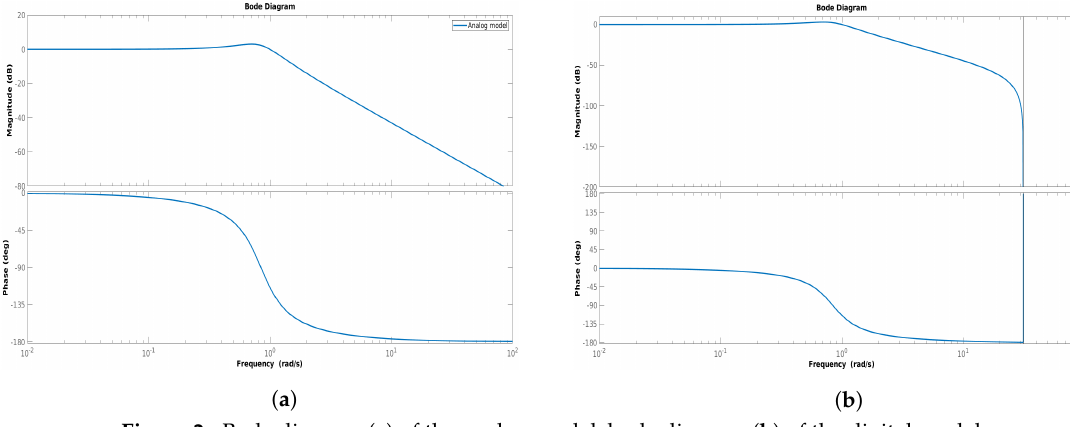
Figure 2. Bode diagram ( a ) of the analog model, bode diagram ( b ) of the digital